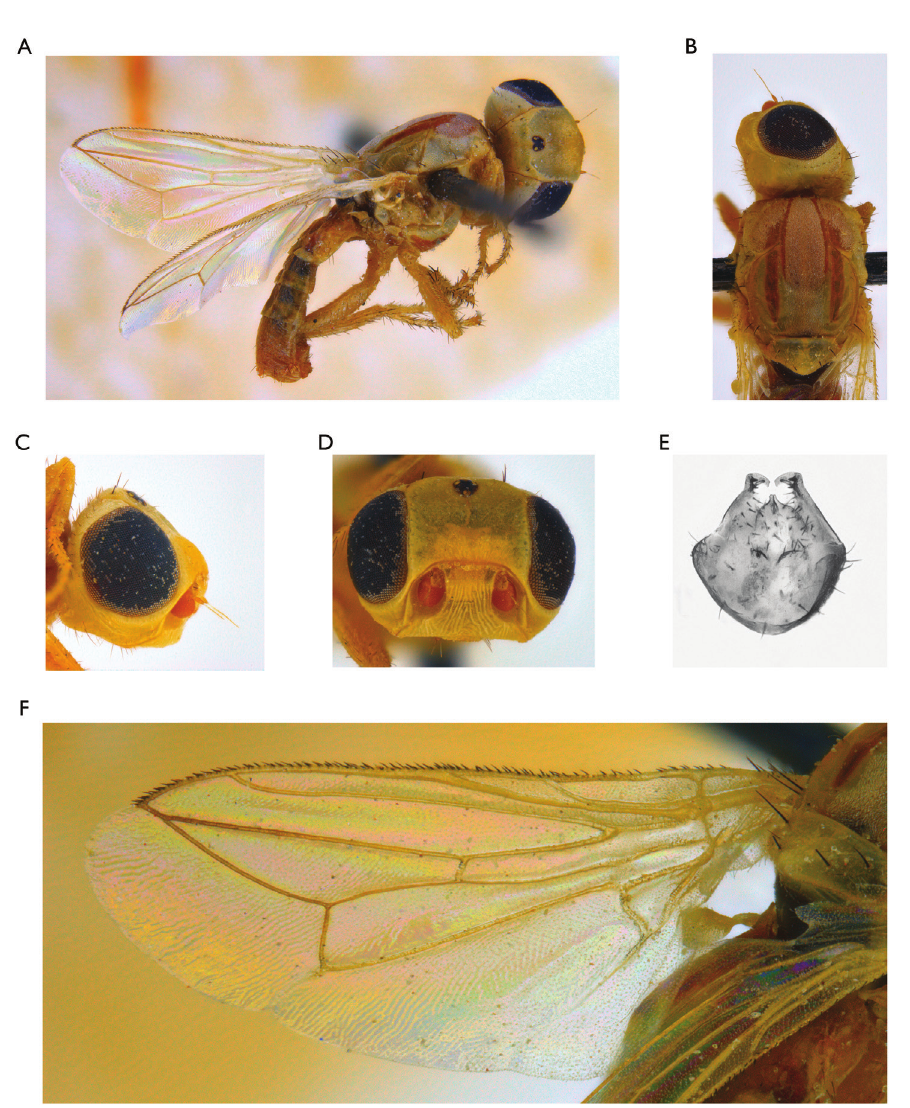
Figure 1. Timia lazebnayae Galinskaya sp. n., paratype male; A habitus, lateral view B head and thorax, dorsal view C head, lateral view D head, anterior view E epandrium, dorsal view F wing. Wings . Hyaline. Cell r completely closed, forming petiolate at wing apex. Pos- 4+5 teroapical extension of cell bcu 0.2 times as short as width of the cell at its middle. Halter yellow. Abdomen . Yellow, non-microtrichose. Male genitalia . Surstylus with anteroventral lobe, curved proximally at right angle, bearing two spines at its medial margin; and with short posteromedial lobe